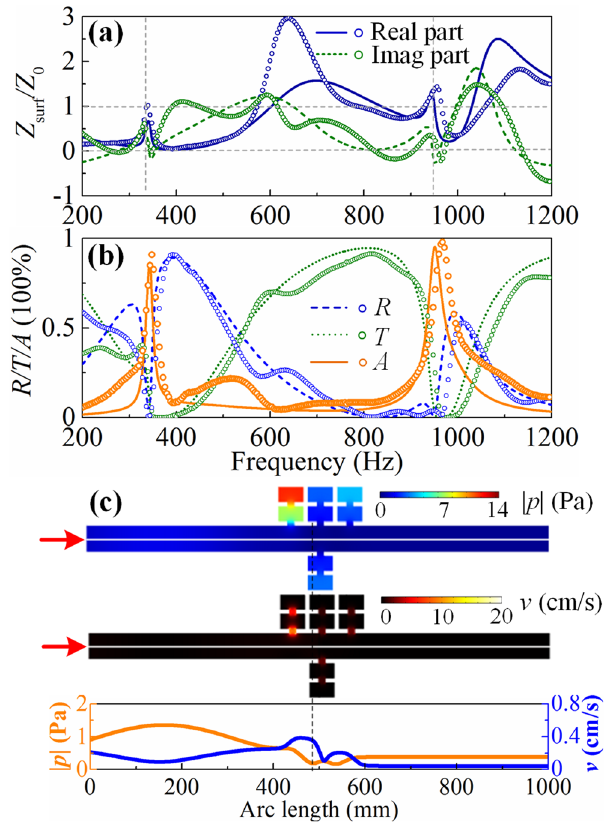
Figure 4. (a) Normalized surface impedance, (b) reflectance (blue dashed line/symbol), transmittance (olive dotted line/symbol) and absorptance (orange solid line/symbol) of the symmetric absorber. (c) The sound pressure and velocity